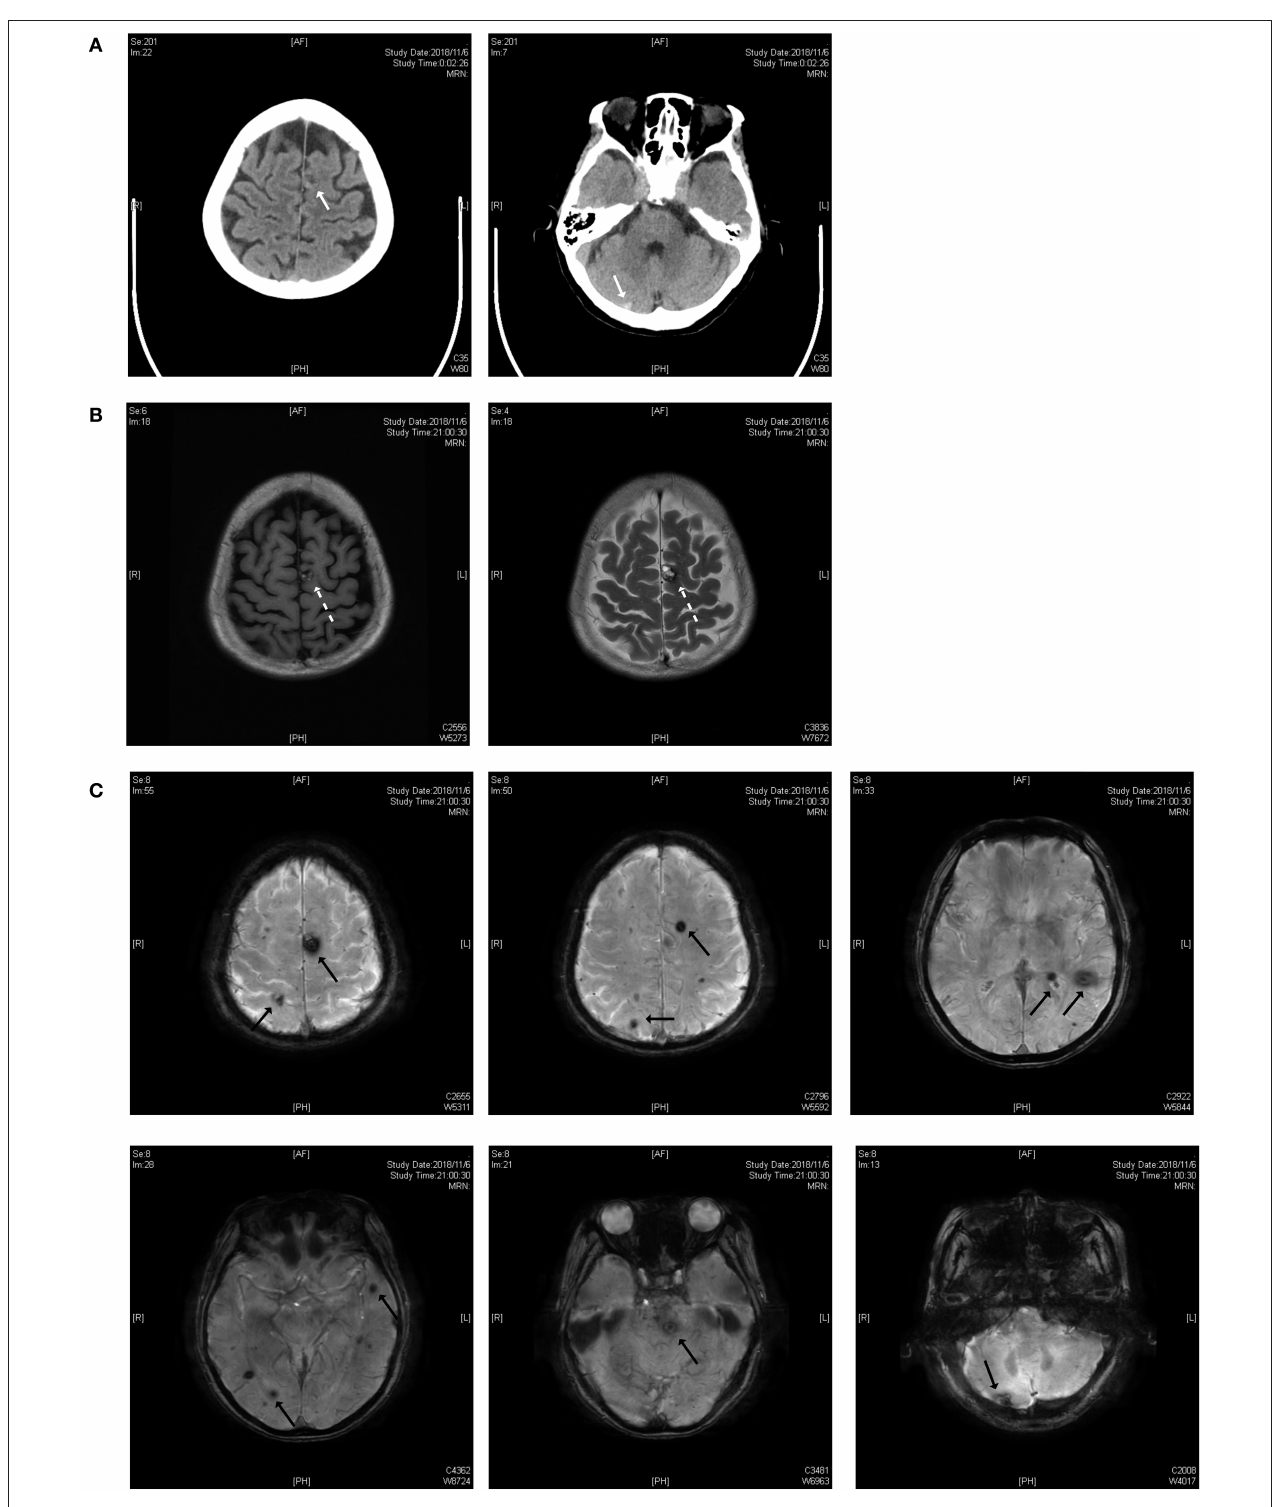
FIGURE 1 | (A) Brain CT scan. The white solid arrows show a mixed-density lesion on the left parietal lobe and a high-density lesion on the right cerebellum. (B) T1 and T2 weighted images of the MRI scan. The dotted arrow indicates a popcorn-like mixed signal on T1WI and a high-signal lesion with a hemosiderin deposit surrounded on the T2 weighted image. (C) Susceptibility-weighted imaging (SWI). Black solid arrows indicate the lesions on the parietal lobe, temporal lobe, brainstem and cerebellum.